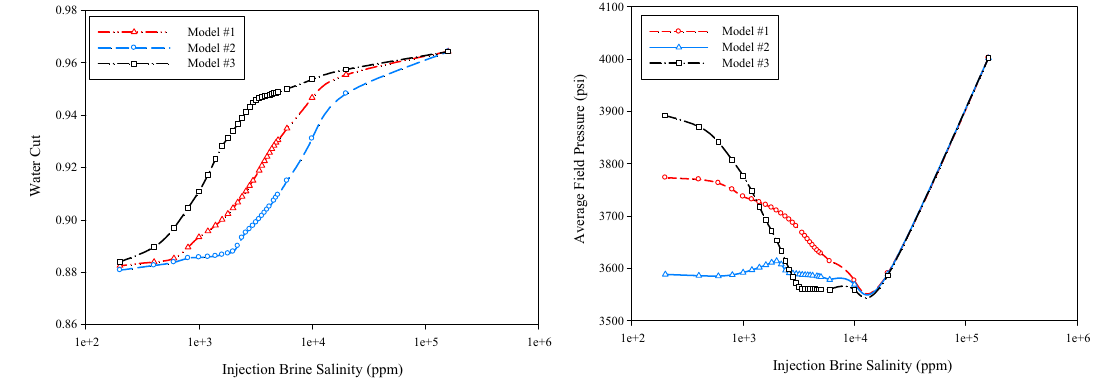
Fig. 16 Effect of injection brine salinity on production well water cut and average field pressure in various salinity threshold